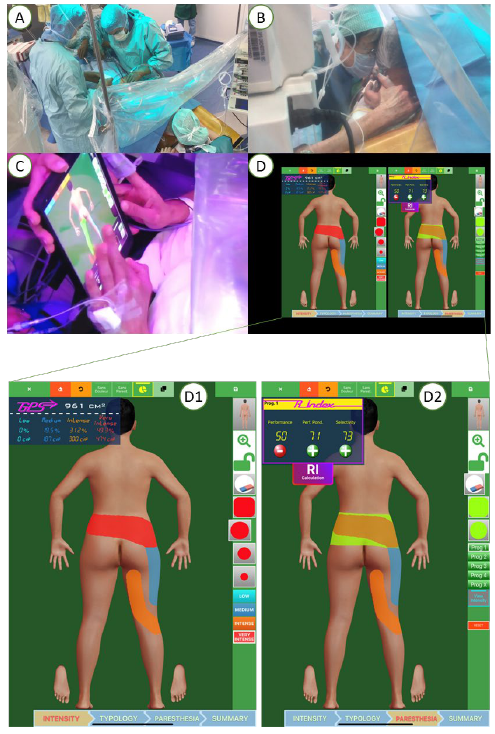
Figure 3. Surgical lead implantation ( A ) under awake surgery with intraoperative hypnosis ( B ) which enabled lead placement on the physiologic midline by intraoperative testing according to patient-reported optimal paresthesia coverage ( C , D ). Pain mapping software used to assess pain surface before implantation ( D1 ) and pain coverage where the patient could draw different painful zones intraoperatively ( D2 ). Data were collected from patients at baseline, and at the 1-, 3-, 6- and 12-month follow-up visits.